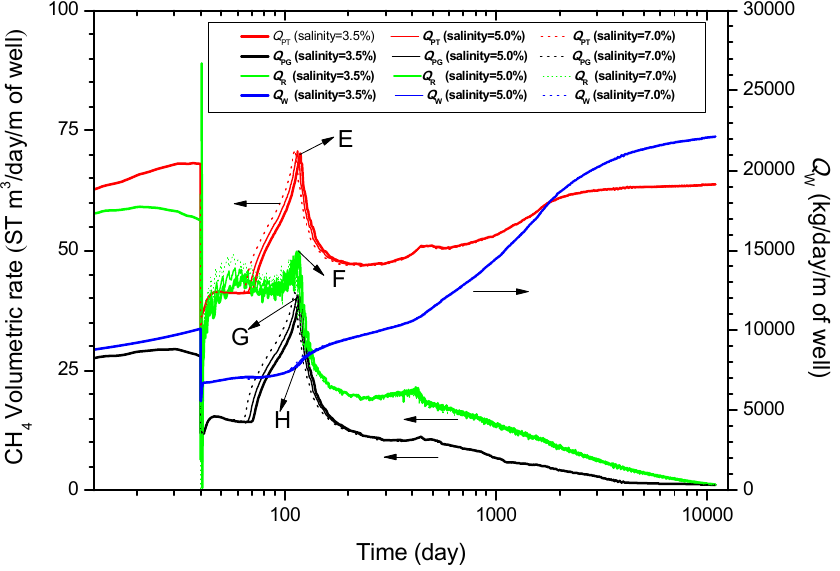
Figure 4. Volumetric rate of CH CH production rate in the gas phase Q 4 Q , and the aqueous phase mass flow rate Q R injected brine during hydrate